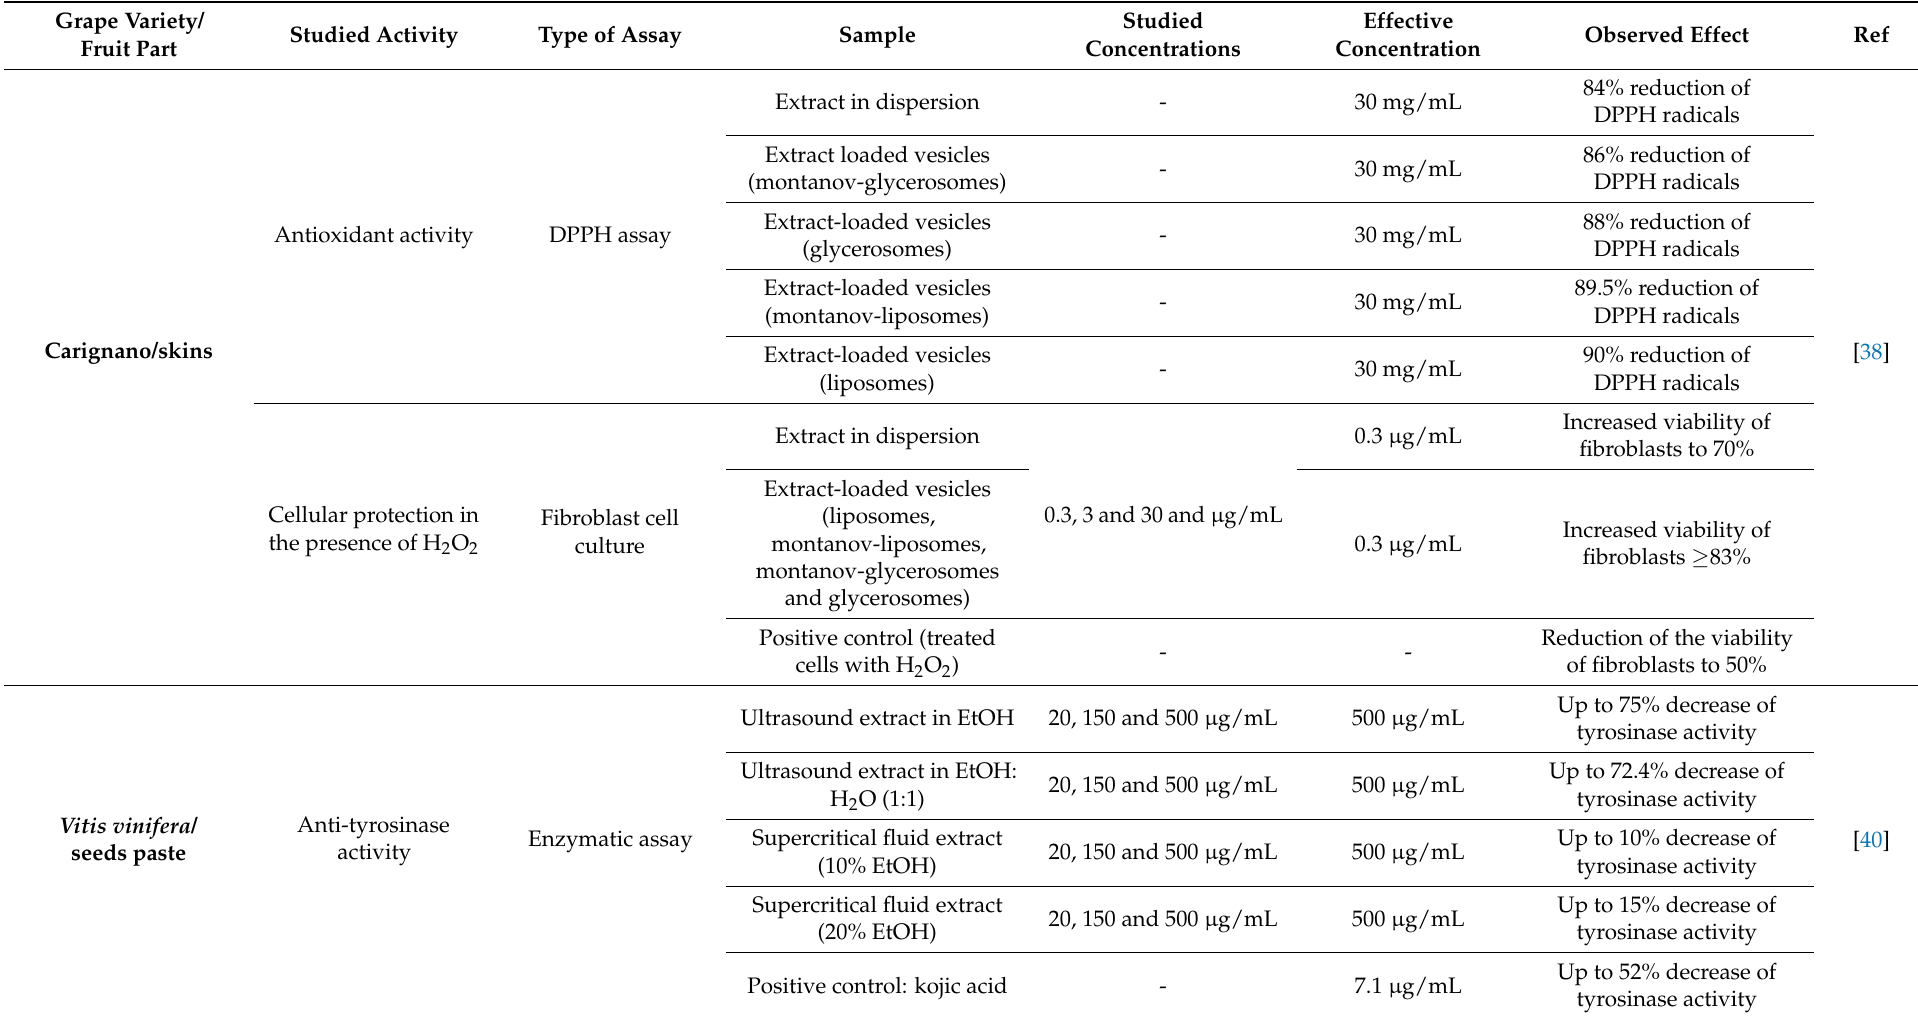
Table 2. In vitro assays conducted on grape pomace extracts with their corresponding studied and effective concentrations as well as their observed